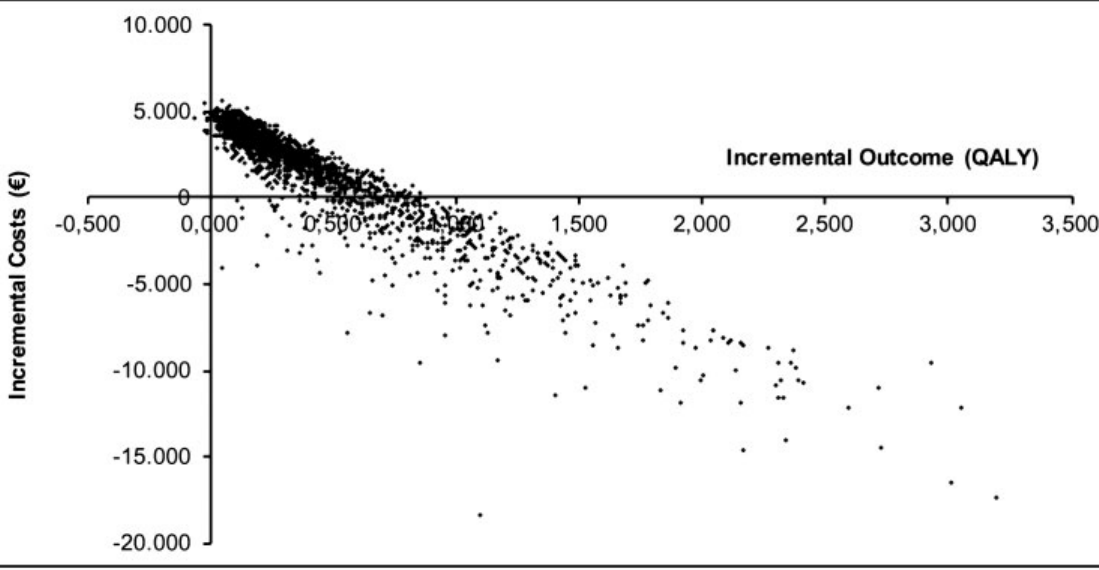
Fig. 1 Probabilistic sensitivity analysis — base-case analysis. QALY, quality-adjusted life-years.